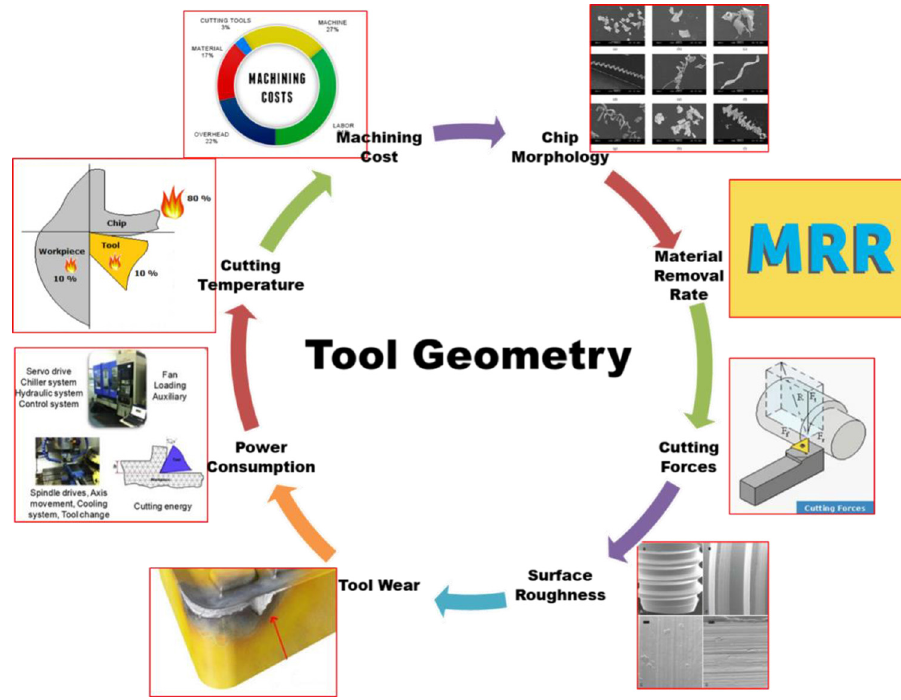
Fig. 5. Technological response parameters affected by tool geometry.